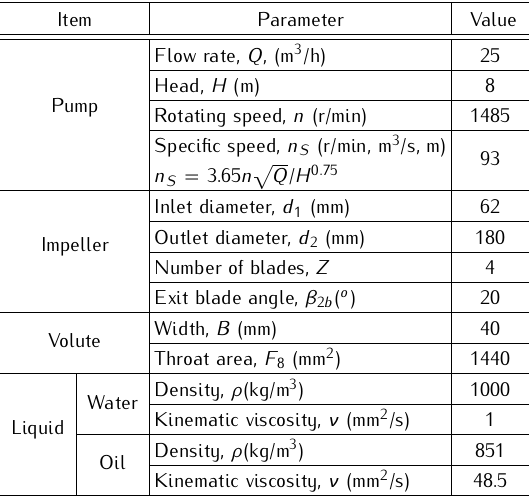
Table 1. Primary parameters of pump, impeller, volute and working